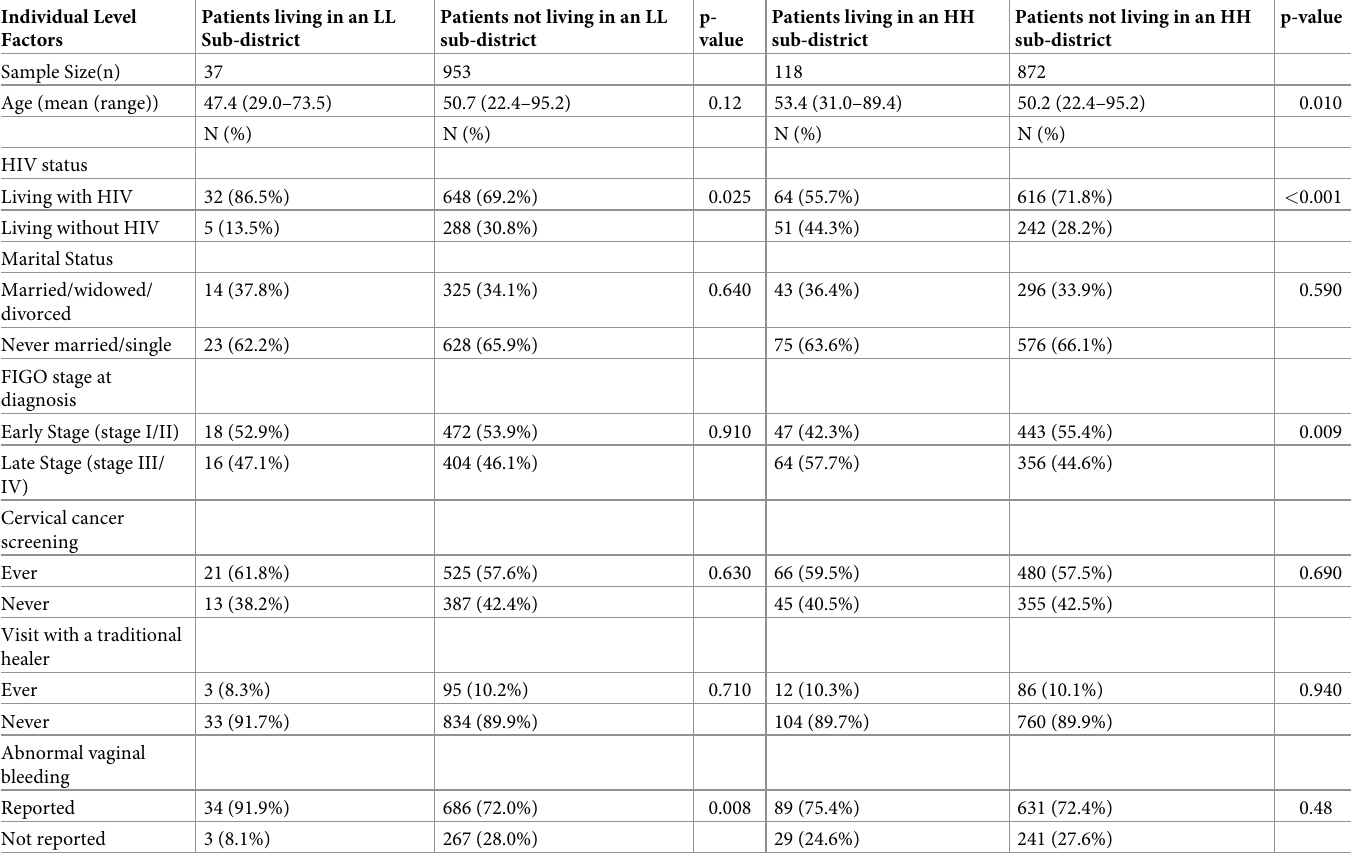
Table 5. Univariate analysis of Individual level factors for patients presenting from identified HH and LL sub-districts. Individual Level